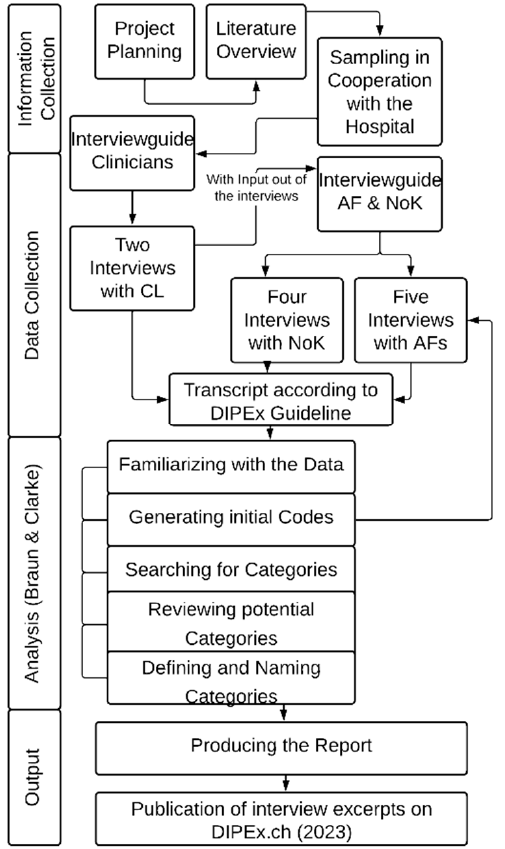
Figure 1. Flowchart of course of the pilot study of aSAH in Switzerland, methodical procedure. Table 1. Guides for semi-structured interviews for (1) clinicians and (2) affected persons and their next of kin.